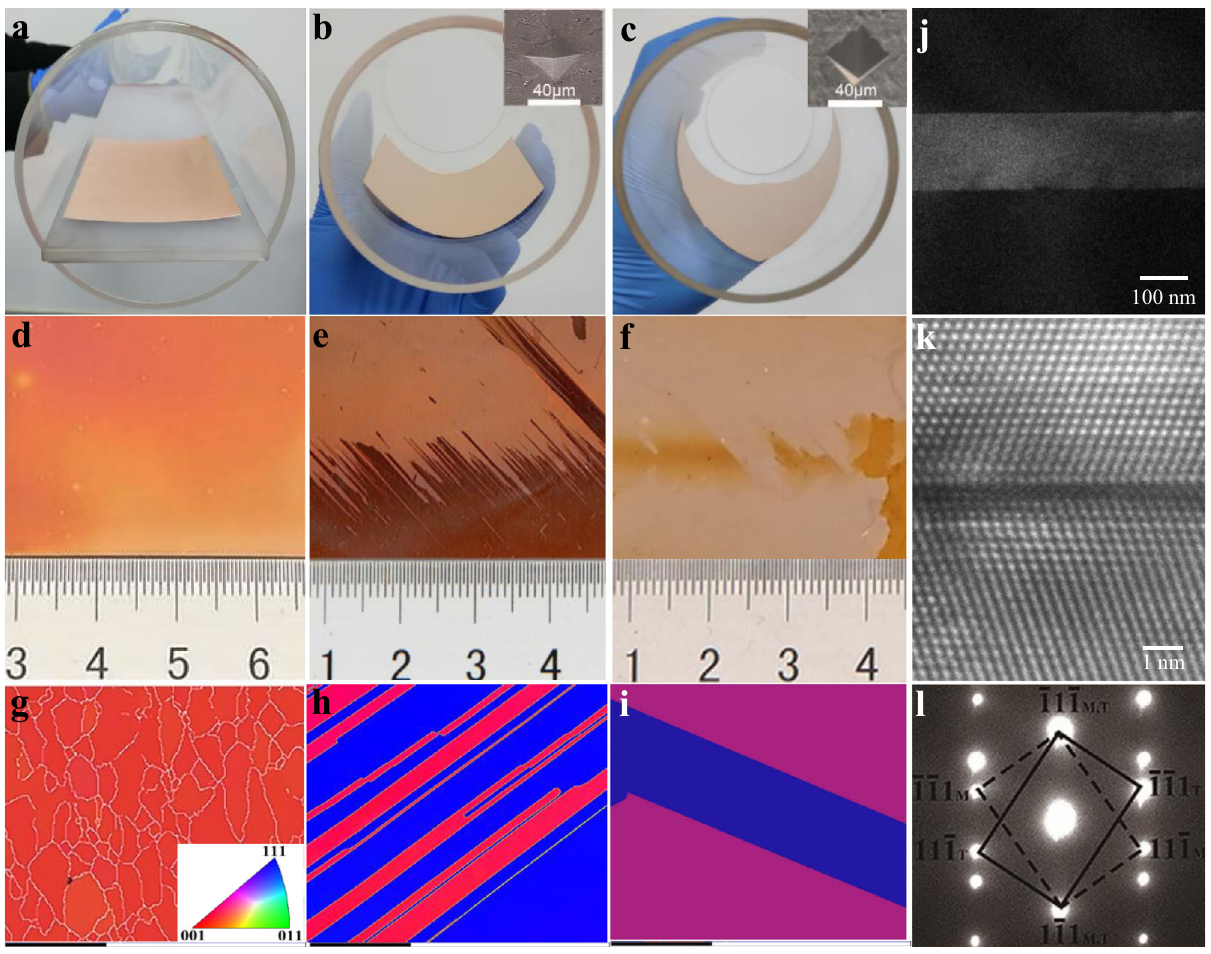
Fig. 2 Cu foils tailoring con fi gurations. a – c Photographs of the annealing experiment setup. d – f Optical images of annealed Cu foil in ( a – c ) after oxidation in air. g – i EBSD characterization corresponding to ( d – f ). The scale bar is 500 μ m. a Annealing a fl at Cu foil. EBSD mapping indicates that the cold rolled foil has been completely recrystallized, forming a polycrystal with relatively fi ne grain sizes (average grain size ~300 µ m) and a strong Cube texture {001} <100>. A small fraction of twinned grains (blue patch) is also seen. b Annealing a bent Cu foil with a microhardness indentation in the center. Introducing an indent is an ef fi cient way to stimulate controlled nucleation and growth during recrystallization; this technique has been used in previous recrystallization and growth studies. EBSD measurements show inch-scale (1 1 6)/(1 1 1) twinned structures. c Annealing a 45° rotated bent Cu foil with a microhardness indentation in the center. EBSD measurements show inch-scale (6 5 5)/(10 2 1) twinned structures. j – l TEM analysis of the obtained twinned Cu structure. Low magni fi cation TEM, high resolution TEM and SAED images of a typical Cu twin crystal are displayed. The nature of coherent twins is con fi rmed. Insets in ( b ) and ( c ) are scanning electron microscopy (SEM) images of the